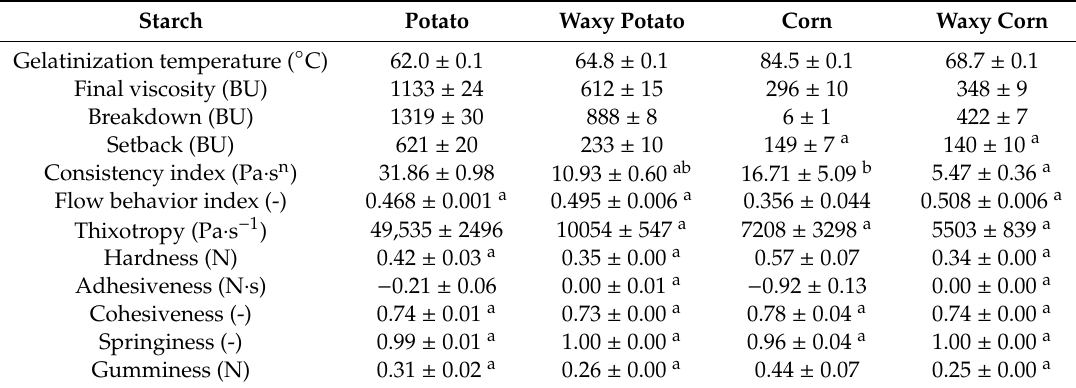
Table 1. Rheological properties and texture parameters of 5% native starch pastes. Starch Potato Waxy Potato Corn Waxy